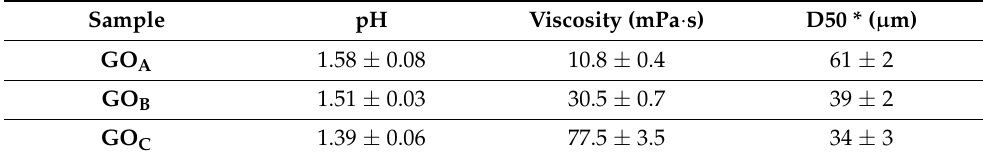
Table 1. Viscosity and laser diffraction (LD) measurements conducted on GO A , GO B and GO C